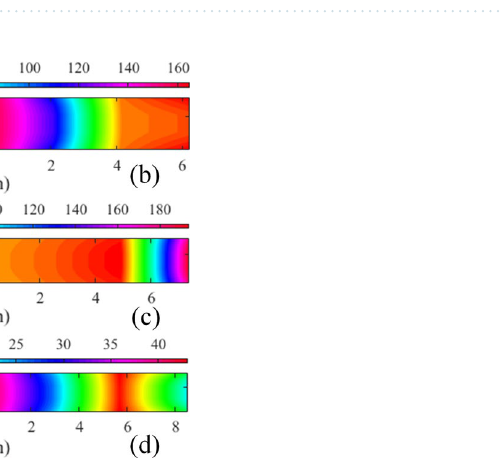
Figure 3. Phase extraction procedure. ( a ) Different cross-sections inside the flare section with variable distances ( d L ) from the horn throat. Phase distribution (in degree) at ( b ) d L = 8 mm, ( c ) d L = 10 mm, and ( d ) d L = 12